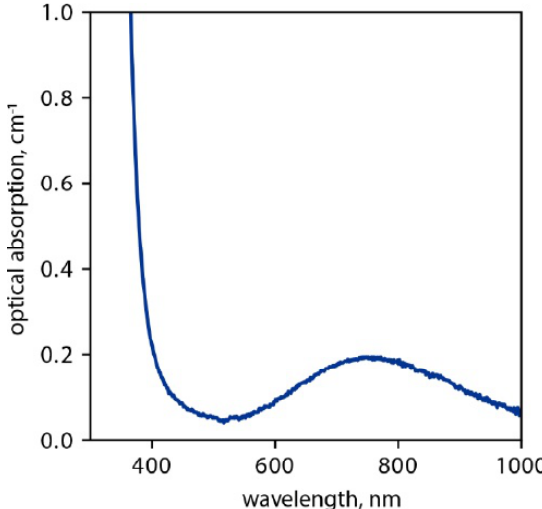
Fig. 1. Optical absorption spectrum of the studied glass.